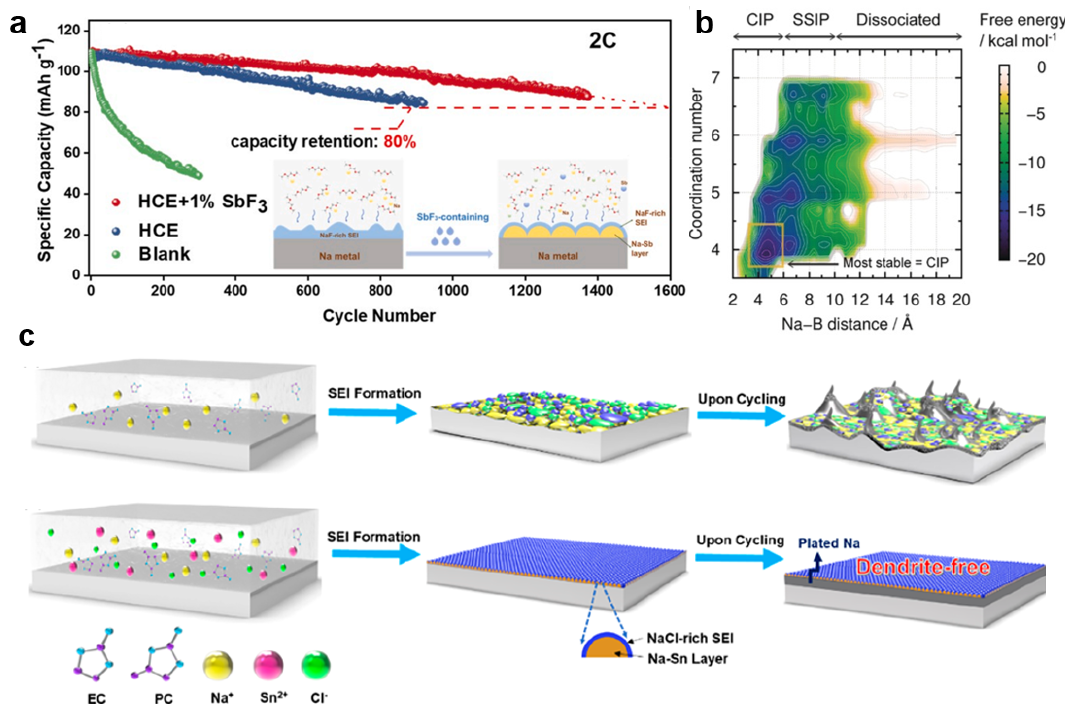
Figure 3. ( a ) Cycling performance. Voltage profiles of the Na||NVP battery tested at 2 C after different cycle numbers using HCE +1%SbF 3 , HCE, and blank electrolyte, the inset is the formation mechanism illustration of a typical SEI layer on the Na metal anode using HCE + 1% SbF 3 electrolytes. Reproduced with permission from Reference [72] Copyright 2020, Elsevier. ( b ) Two-dimensional free energy surface for the ion-pair distance and coordination number between Na and DME of NaBPh 4 /DME solution, reproduced with permission from Reference [80] Copyright 2019, Wiley − VCH. ( c ) Schematics of the typical mosaic SEI on the Na metal anode cycled in regular carbonate electrolyte and the in situ formed Na-Sn alloy layer plus a NaCl-rich SEI layer. Reproduced with permission from Reference [74] Copyright 2019, American Chemical Society.